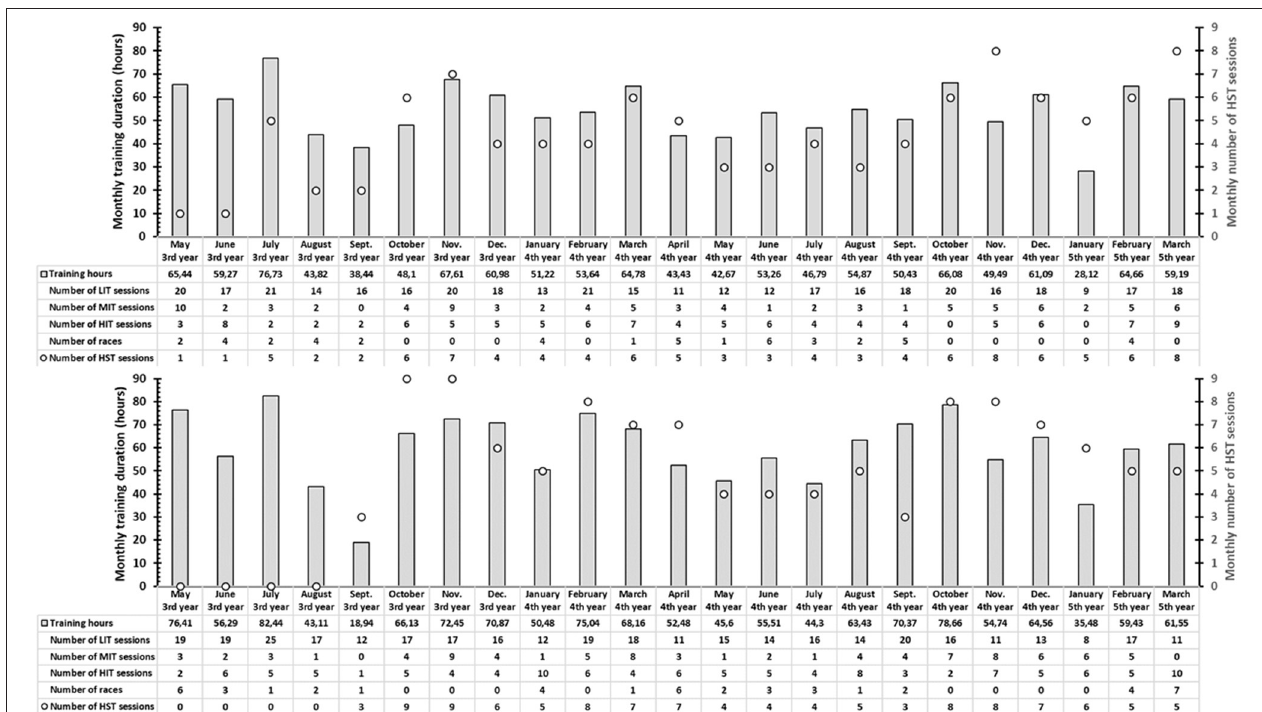
FIGURE 2 | Monthly training duration (bars, y1-axis), monthly number of heavy strength training sessions (circles, y2-axis), monthly number of low-intensity training (LIT) sessions, moderate-intensity training (MIT) sessions, and high-intensity interval training (HIT) for the cyclist continuing with heavy strength training after the first part ( EandS1 ; upper panel) and the cyclist who started with heavy strength training in the preparatory period after the first part ( E1 + EandS ; lower panel). Data start with the competition period via the preparatory period, new competition period, and start of the last preparatory period, and conclude at the start of the following competition period (i.e., 2